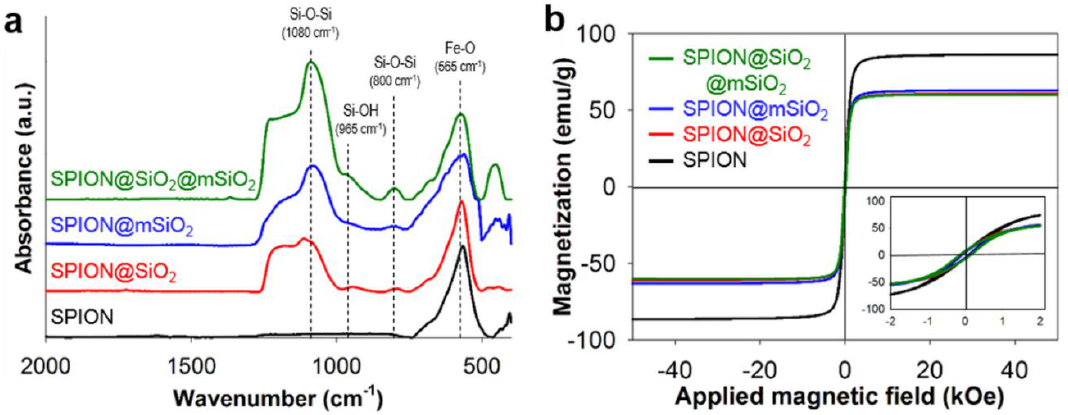
Figure 2. Fourier transform infrared spectroscopy (FTIR) spectra of the nanoparticles ( a ) and magnetization curves of the nanoparticles at 300 K ( b ).